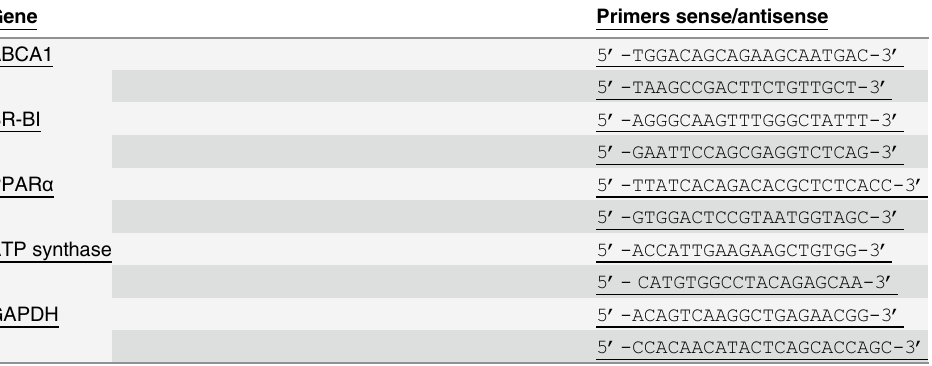
Table 1. Sense/antisens primers used for ABCA1, SR-BI, PPAR α , ATP synthase β chain and GAPDH relative quantification. (PPAR α : peroxisome proliferator-activated receptor α , ABCA1: ATP binding